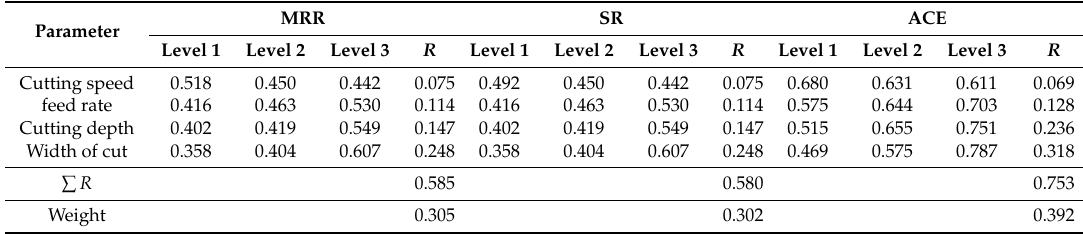
Table 3. Weight calculation for each response using Grey entropy weight.